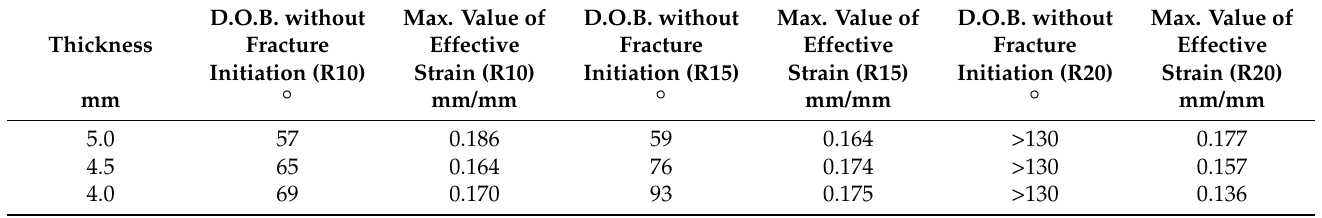
Table 4. Three-point bending (3PB) experiment results.